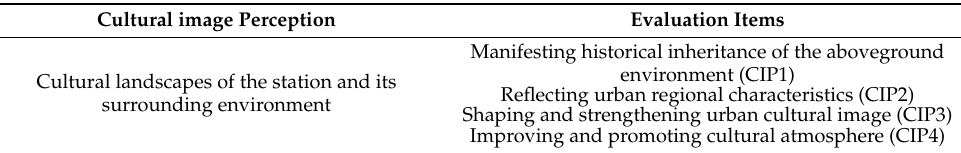
Table 3. Evaluation indexes of cultural image perception.